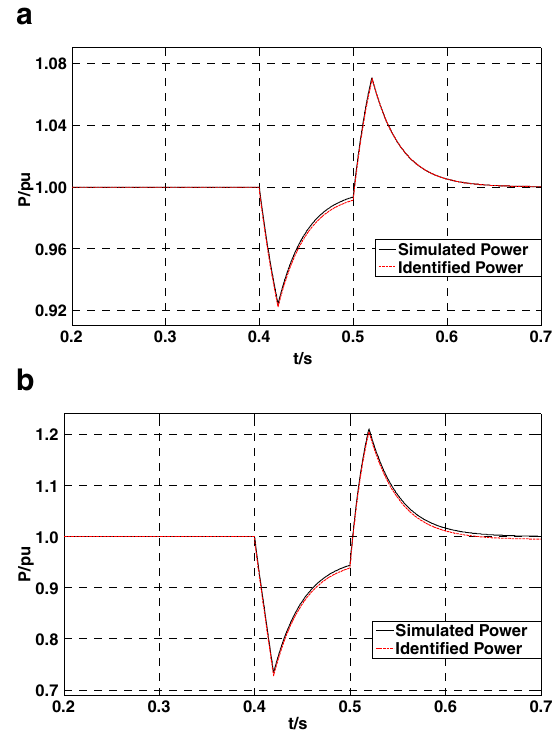
Fig. 6 Voltage disturbance curve and fitting curve of the model under continuous small disturbance Fig. 7 Interpolation and extrapolation capability